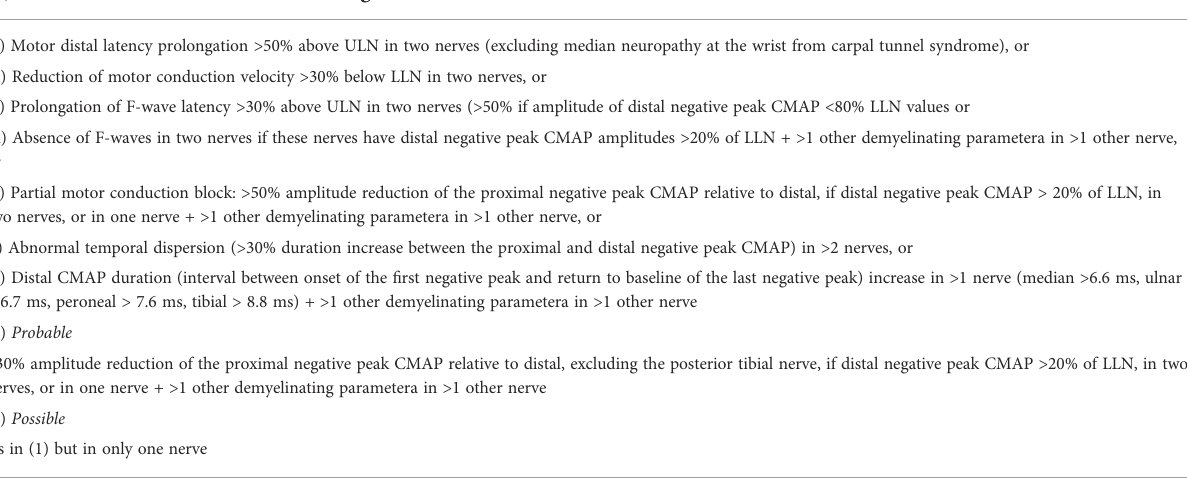
TABLE 2 EFNS/PNS electrodiagnostic criteria for